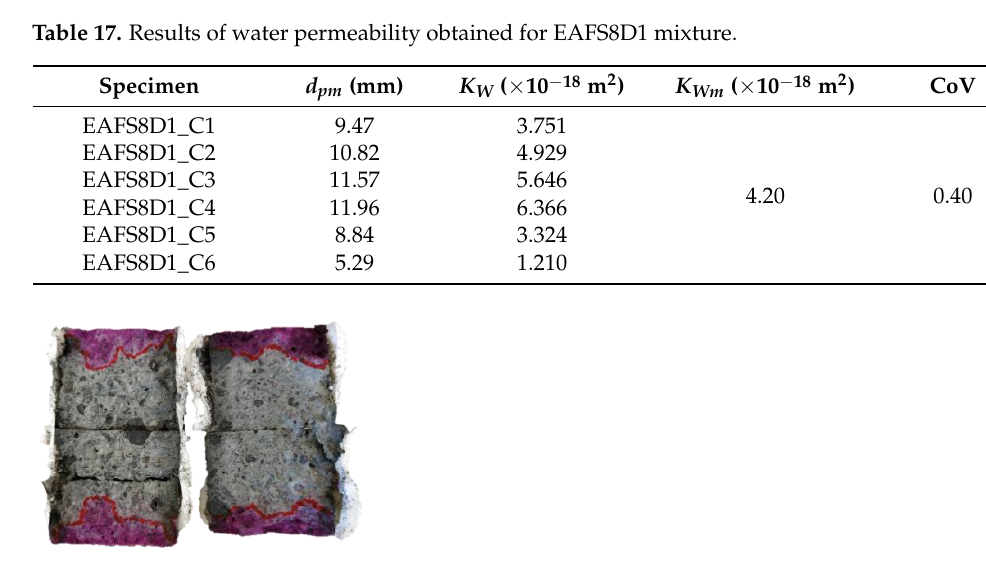
Table 17. Results of water permeability obtained for EAFS8D1 mixture.